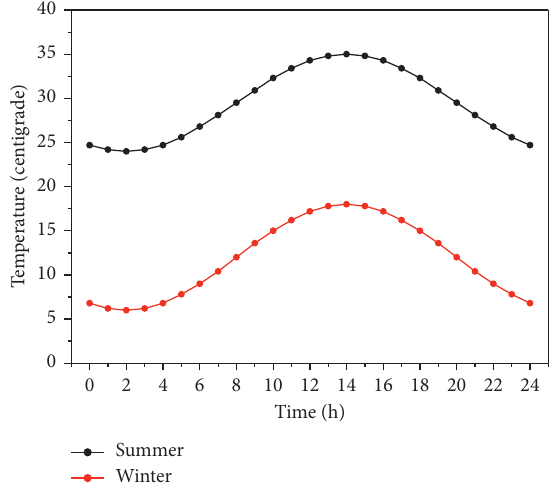
Figure 5: The temperature variation of the